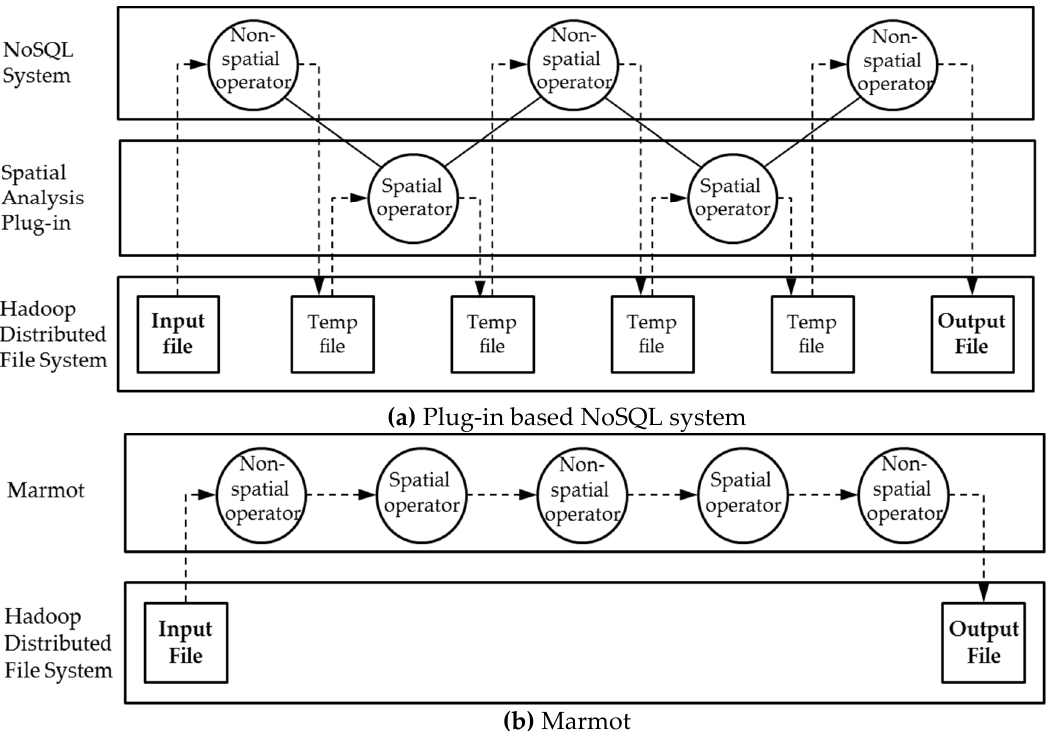
Figure 2. Comparison of two Hadoop-based architectures integrating spatial and nonspatial operations: ( a ) Plug-in based NoSQL system and ( b ) Marmot.